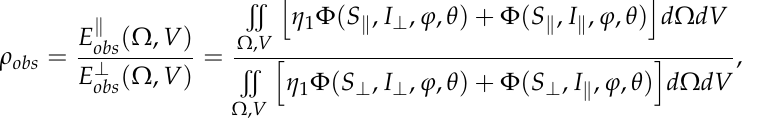
and S denote ⊥ (cid:107)